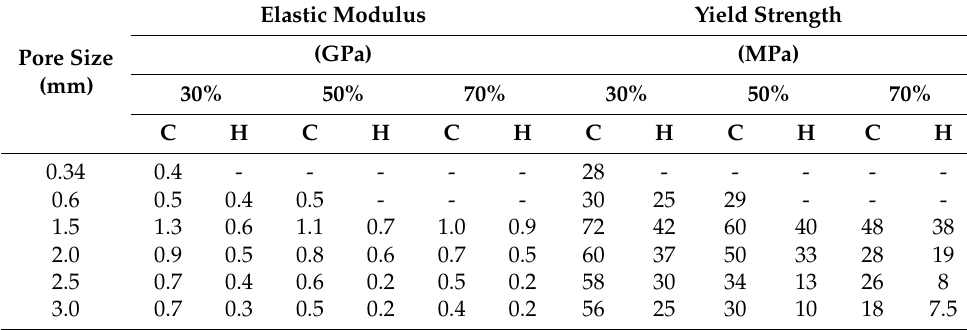
Table 5. Mechanical properties of PolyJet 3D-printed scaffold